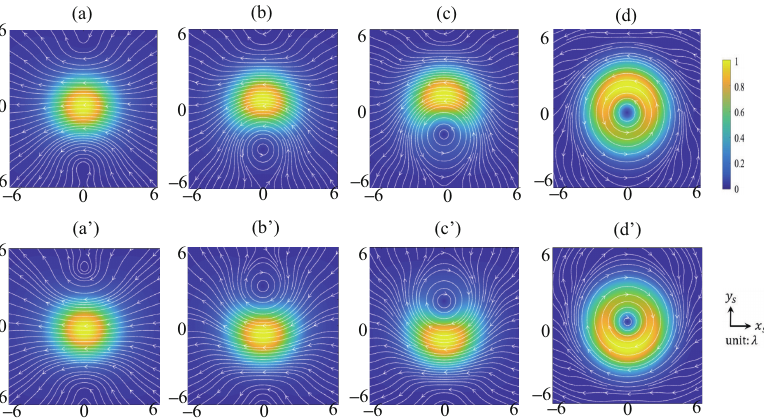
Figure 6. The transverse energy flux s xy with flow lines and strength | s xy | on the focal plane for | σ c | (cid:54) = 1. Here, ( a ) σ c = 0.2, ( a’ ) σ c = − 0.2, ( b ) σ c = 0.8, ( b’ ) σ c = − 0.8, ( c ) σ c = 1.5, ( c’ ) σ c = − 1.5 and ( d ) σ c = 10, ( d’ ) σ c = − 10. In all plots, a = 0.5 w 0 , f = 2 mm, w 0 = 2 mm and α = 60 ◦ . The transverse energy flux s xy for | σ c | (cid:54) = 1 along the propagation direction